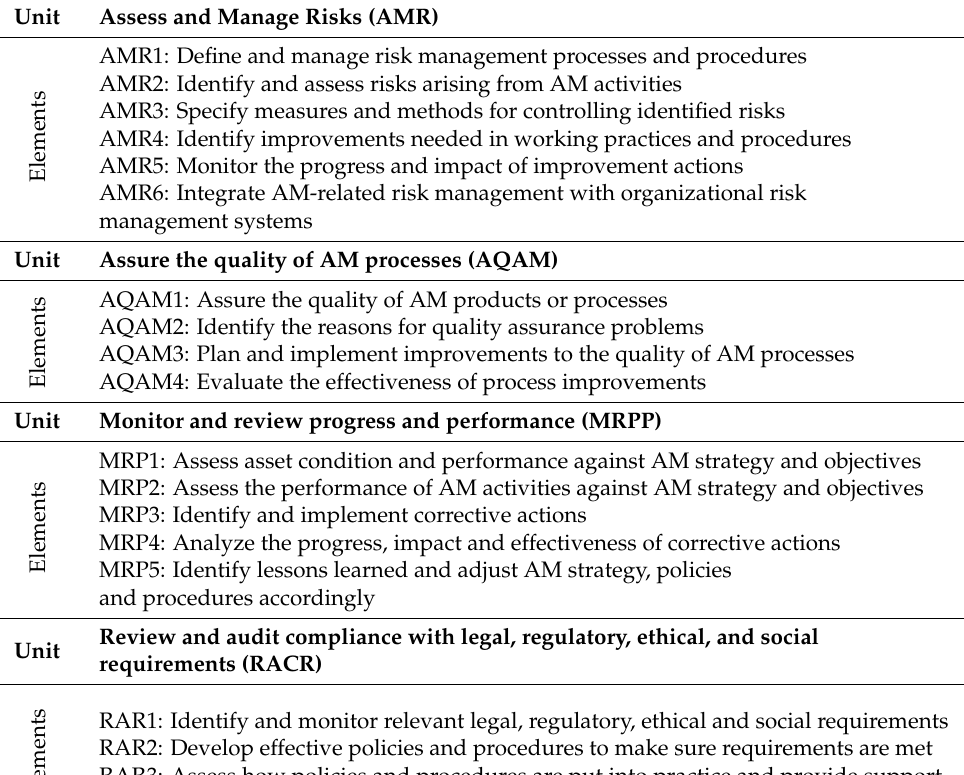
Table A2. List of criteria and sub-criteria for the risk management and performance improvement role (source: